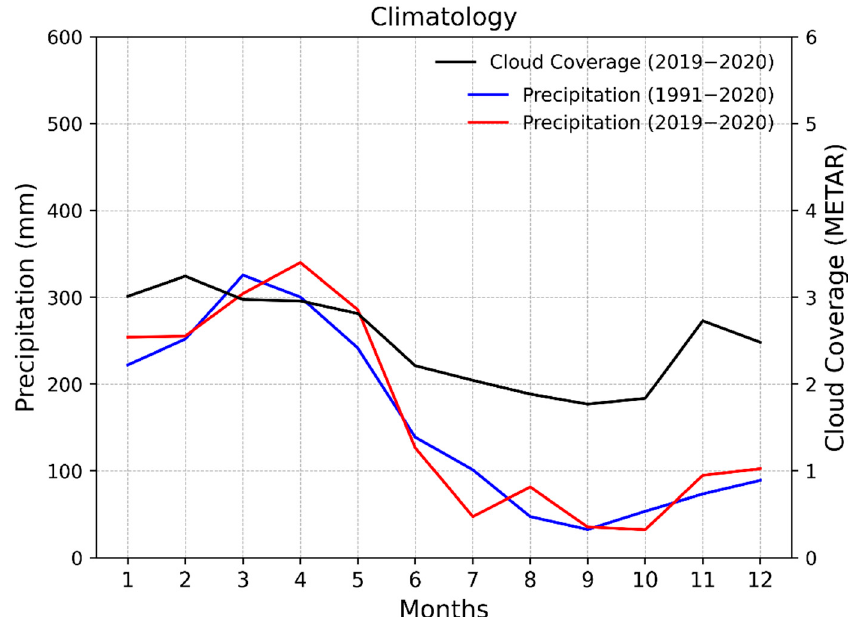
Figure 4. Cloud cover and precipitation monthly average at Santarém.